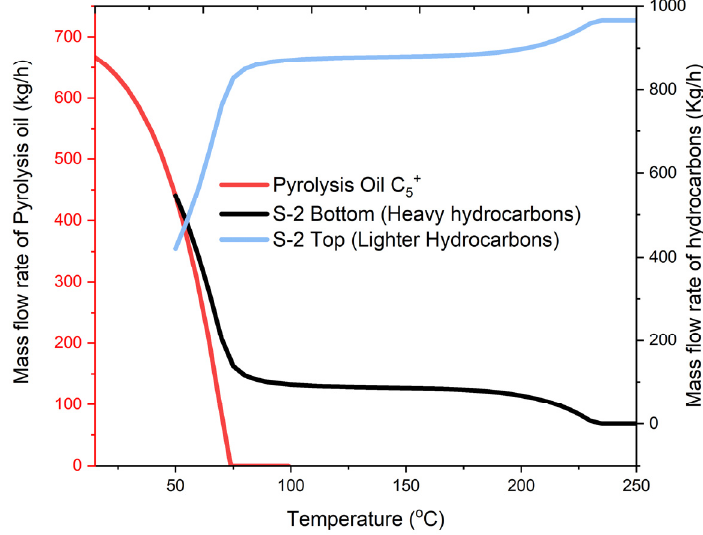
Figure 5. Sensitivity and optimization analysis of the pyrolysis process.